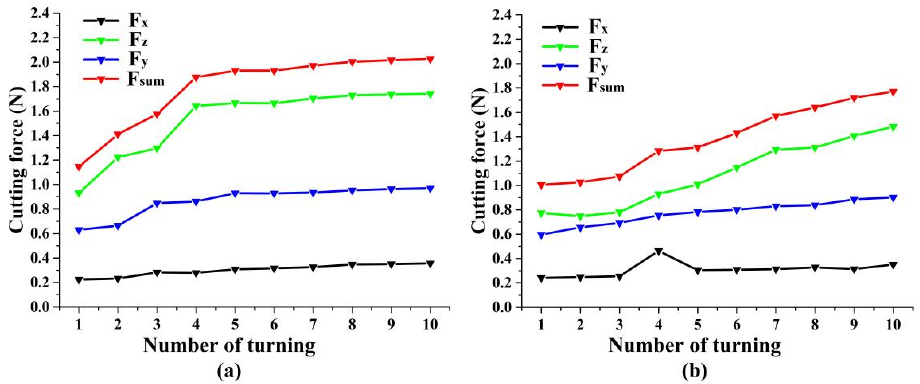
Figure 12. Turning forces of non-textured ( a ) and textured PCD tool ( b ) in 10 turnings.